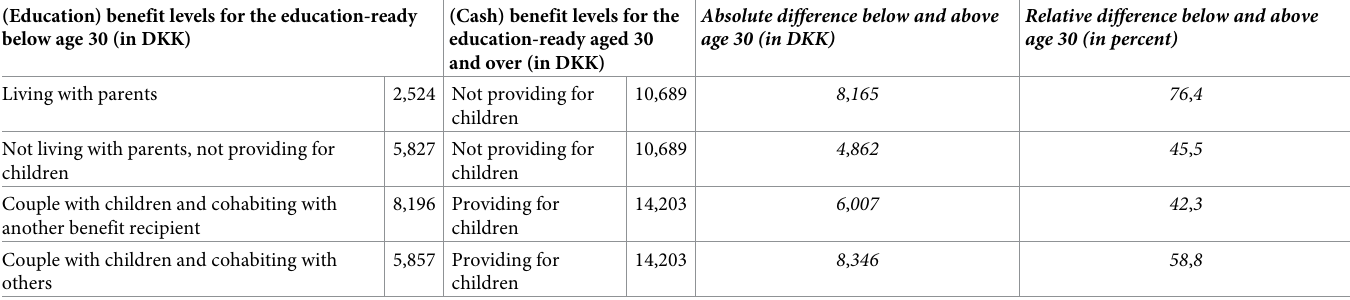
Table 1. Benefit levels for the education-ready in 2014, by living arrangements, parenthood and age. (Education) benefit levels for the education-ready below age 30 (in DKK)